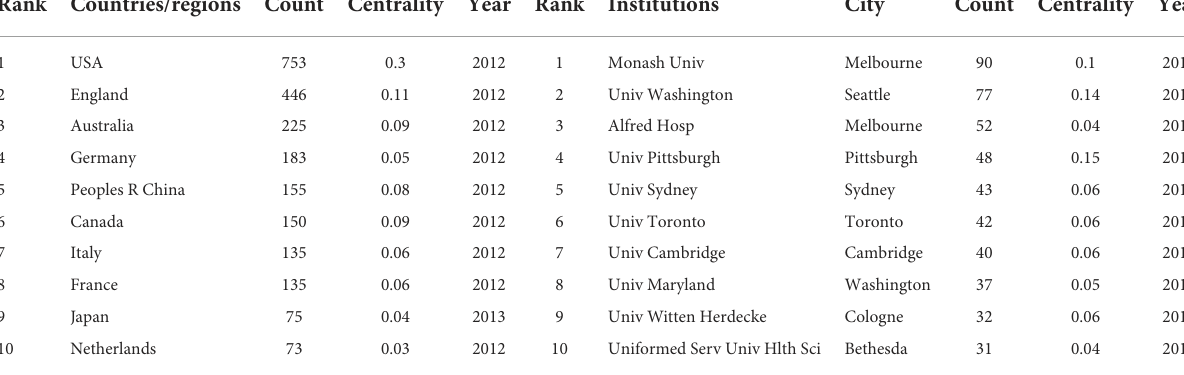
TABLE 1 The top 10 productive countries/regions and institutions. Rank Countries/regions Count Centrality Year Rank Institutions City Count Centrality Year